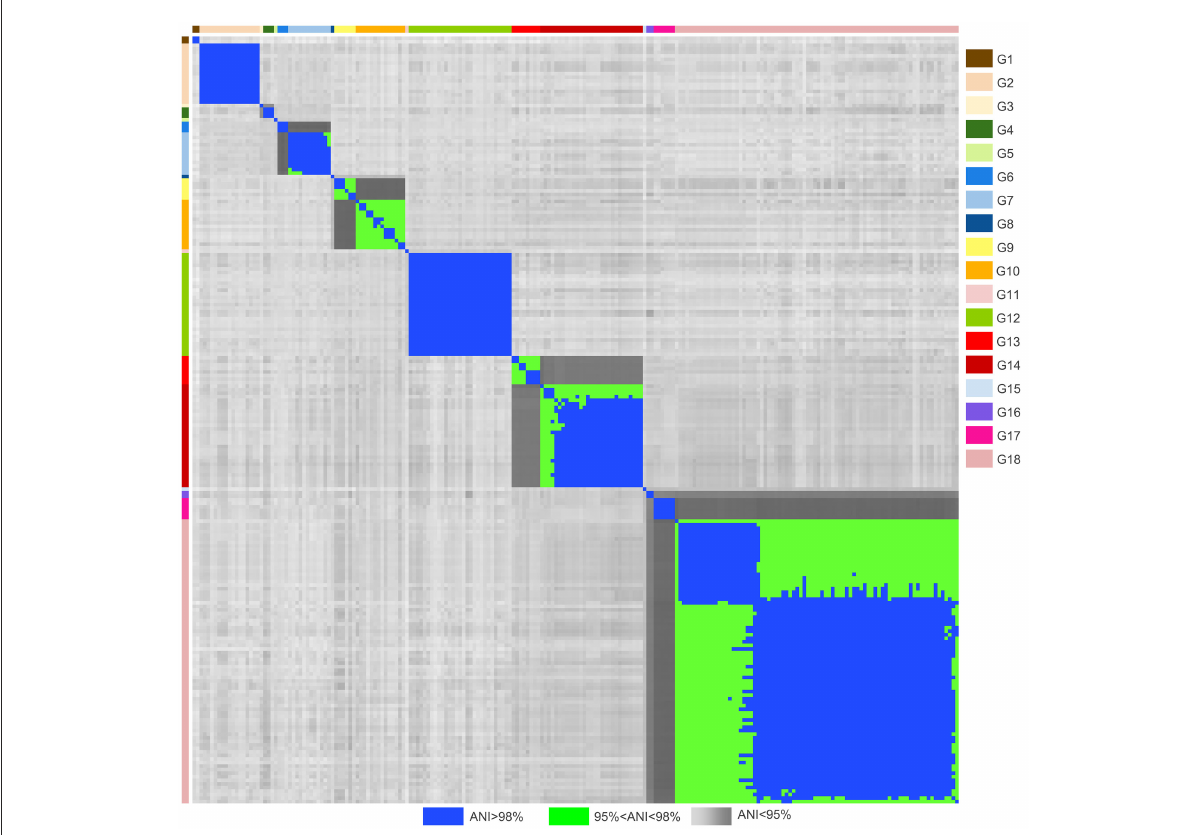
FIGURE1 Heatmap of the ANI similarities matrix reporting pairwise ANI values of 216 Leuconostoc genomes. Blue, ANI > 98%; green, 95% < ANI < 98%; gray shades, ANI < 95% (77–94.9%). Strain labels are colored according to the